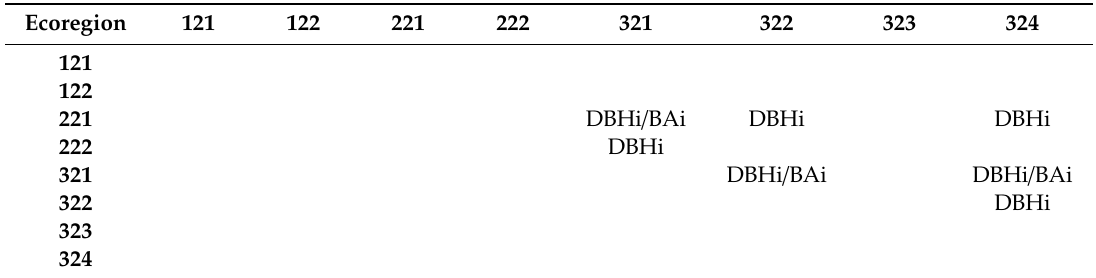
Table 6. Impact on growth of Sessile oak by ecoregions assessed with the estimated marginal means. Ecoregions not significantly different are identified for DBH increment and basal area increment with DBHi or BAi, respectively. The empty cells indicate significant difference.